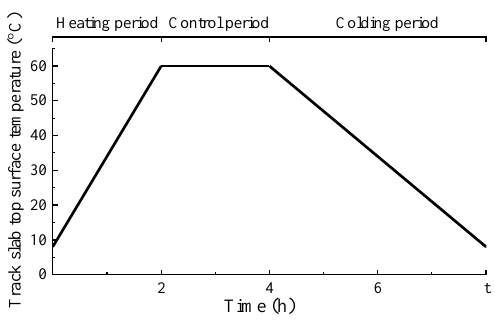
Figure 3. Design temperature loading system.